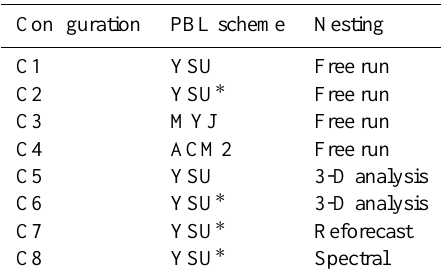
Figure 4. Time series of wind speed for a 6-day period around storm Lothar averaged for 109 stations. The thick black line depicts the series corresponding to the observations, whereas the coloured lines correspond to the simulation results with different model set-ups (Table 2). Table 2. Summary of the eight model configurations used in the sensitivity studies.